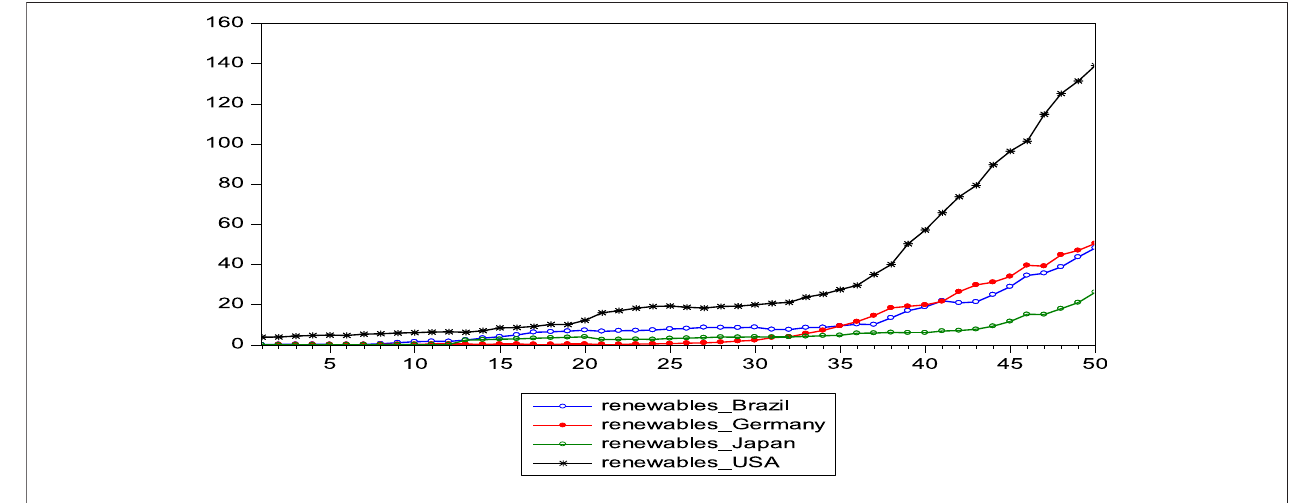
FIGURE 1 | Renewable energy consumption.